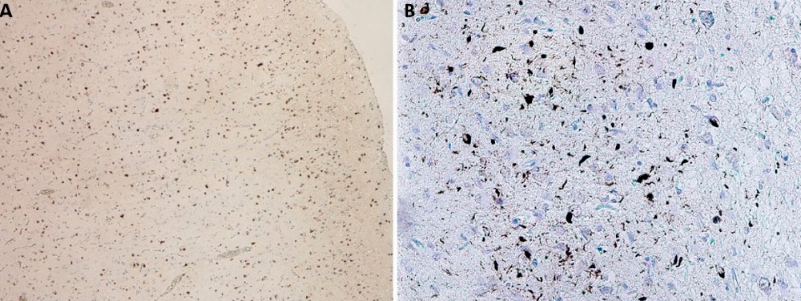
Figure 5. Neuropathological finding showing changes in FTLD-TDP. ( A ) Temporal cortex, numerous neuronal cytoplasmic inclusions in all layers of neocortex, stained with monoclonal antibody (phospho-TDP-43) against hyperphosphorylated TDP-43 protein, original magnification 40×; ( B ) cytoplasmic inclusions in residual neurons nuclei nervi hypoglossi , stained with monoclonal antibody (phospho-TDP-43) against pathologically changed TDP-43 protein, magnification 200×.